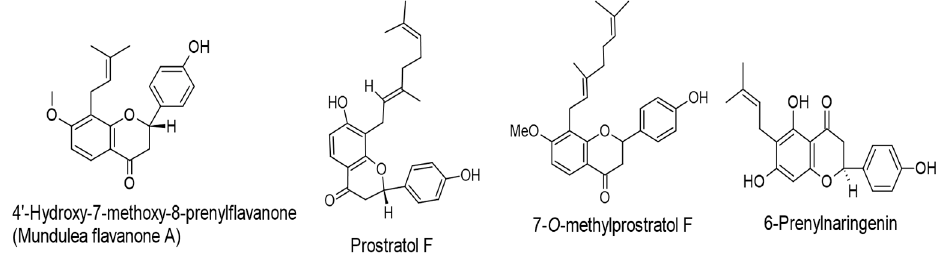
Figure 5. Chemical structures of flavanones with therapeutic properties against EBV-associated